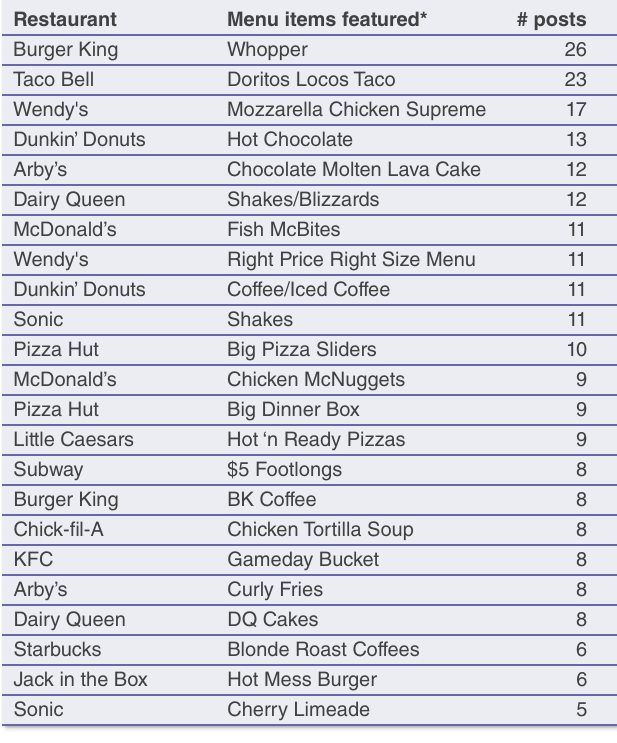
Table 36. Menu items featured most often in Facebook